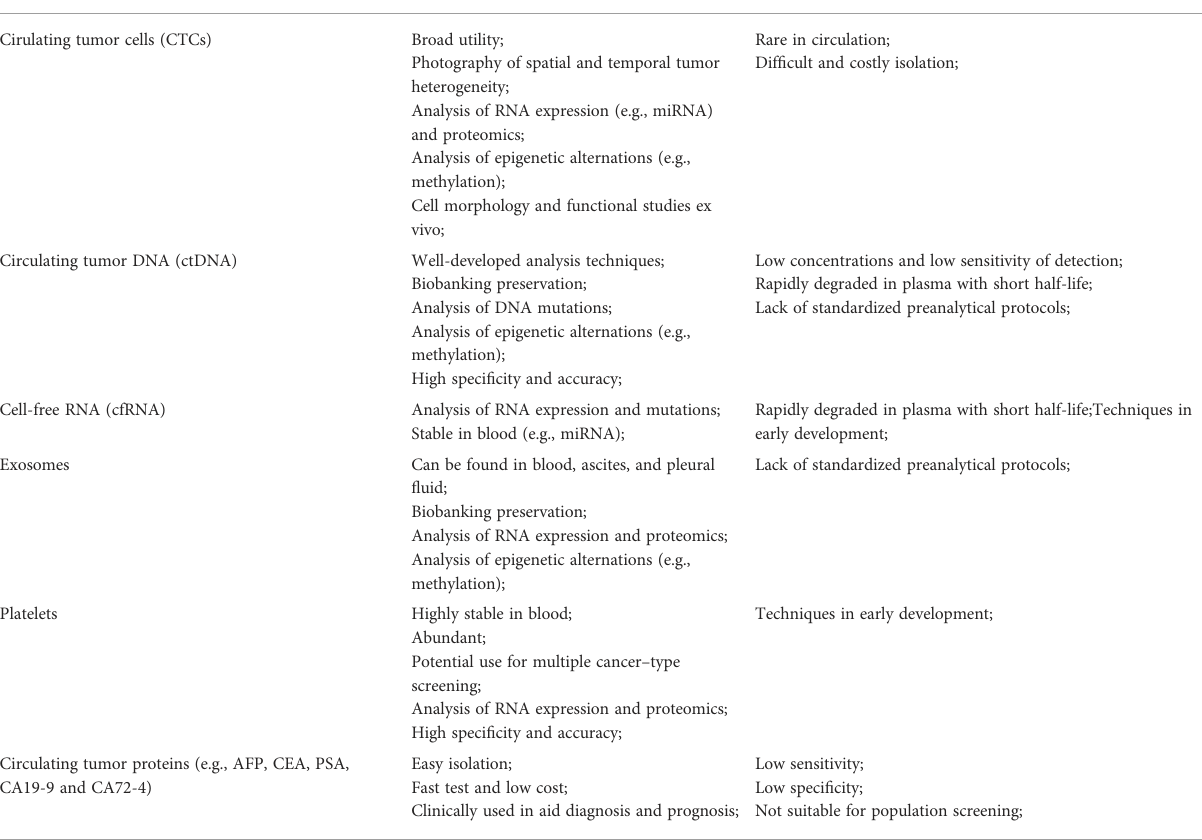
TABLE 1 Comparison of liquid biopsy methods for cancer diagnosis and prognosis.